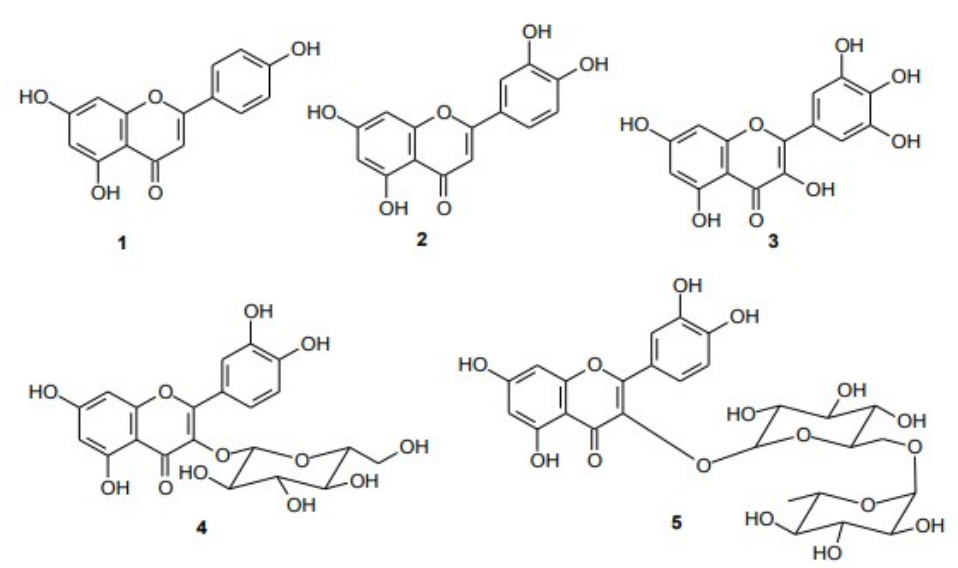
FIGURE 1 - Structures of the flavonoids identified in ethanolic extract from P. venusta . TABLE II - LC-MS/MS parameters of the five flavonoids identified in the Pyrostegia venusta crude ethanolic extract